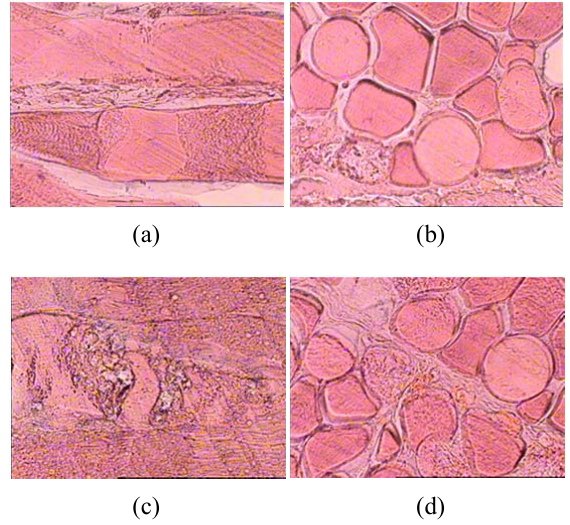
Fig. 2. Contraction knots in the structure of muscle tissue (the carcass of a turkey hen 5 hours after the slaughter, the longitudinal and cross sections, respectively): (a, b) pectoral muscles; (c, d) femoral